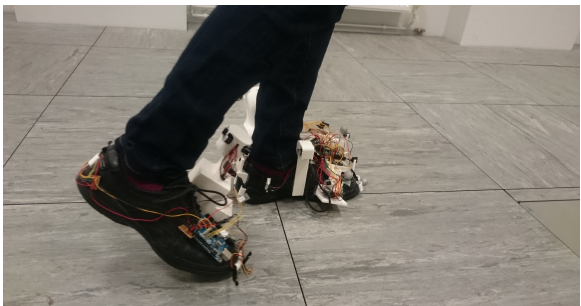
Figure 5. The wearable sensing system during Type 1 walking. The left foot is on the ground when the zero-velocity updates (ZUPT) and Heuristic Drift Reduction (HDR) corrections are